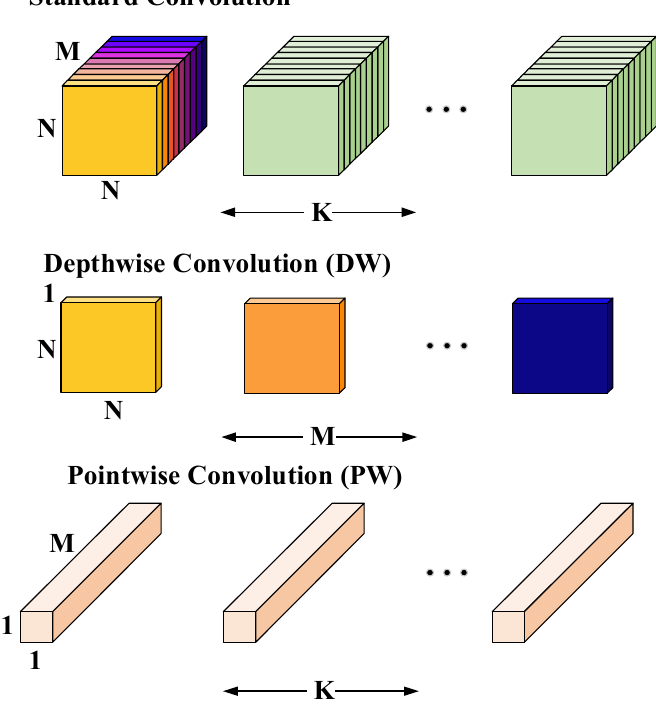
Figure 4. Standard convolution and depthwise separable convolution.